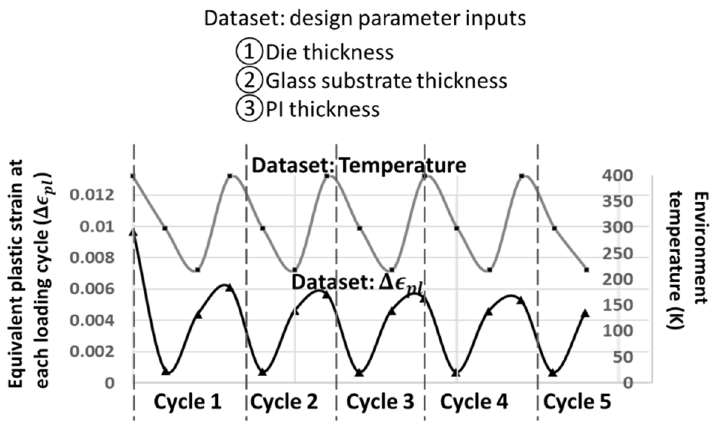
Figure 10. The FE